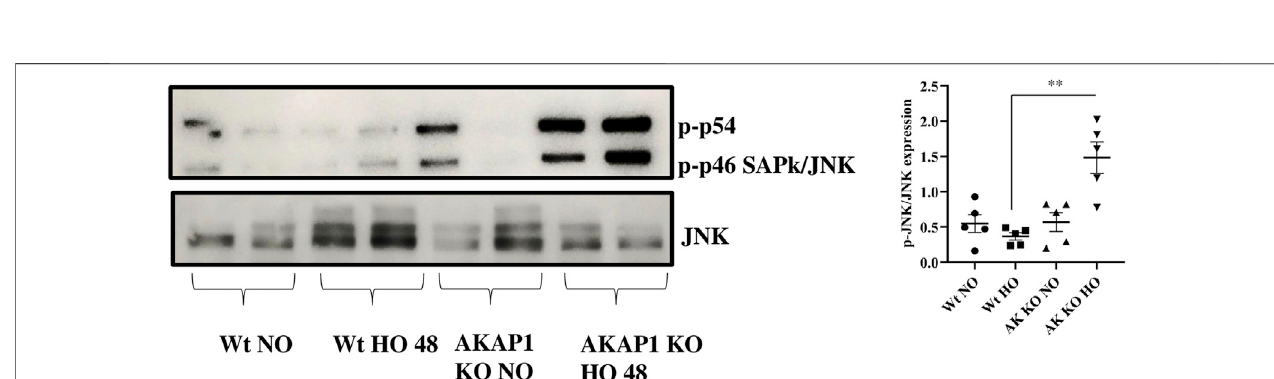
FIGURE2| Akap1 geneticdeletion activatesBiPafterhyperoxicexposure: Wt and Akap1 micewereexposedtonormoxiaandhyperoxiafor48 h.Afterhyperoxia, the mice were killed, and protein from the lungs was extracted and subjected to Western blot analysis to evaluate the expression of BiP, and β -actin was used as a loading control. Densitometry analysis of protein was carried out, and fold change was calculated after normalizing to β -Actin. Data are shown as mean ± S.E.M (* p < 0.05) (n = 5 mice per group), NO, normoxia; HO, hyperoxia; AK, Akap1 ; KO: Knockout.